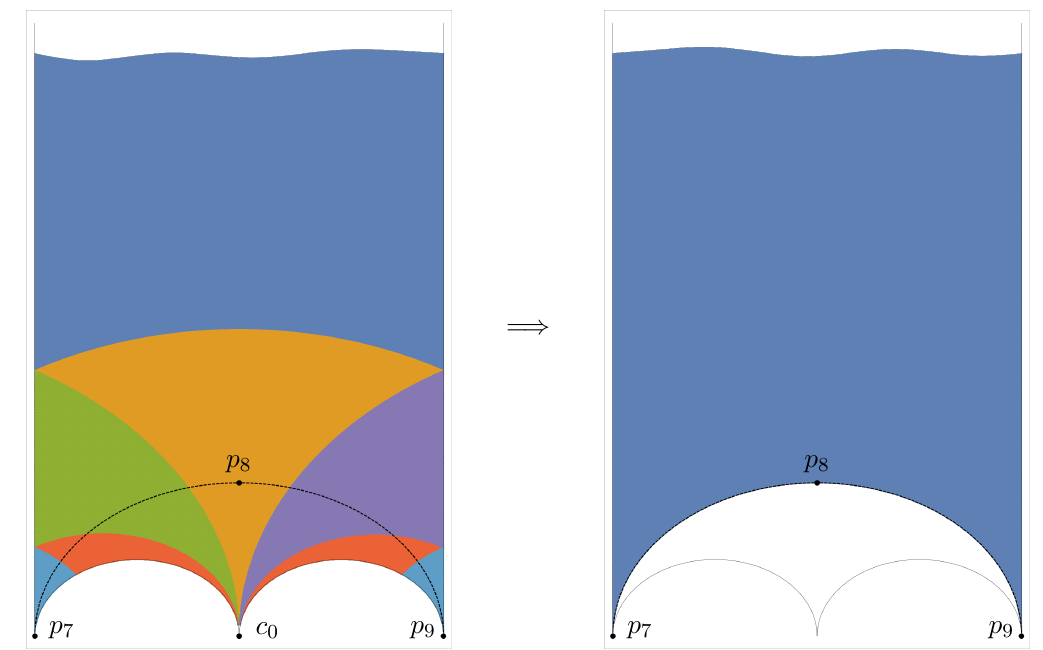
(4) /F . The marked points are 0 4 and c = 0 is the 4 0